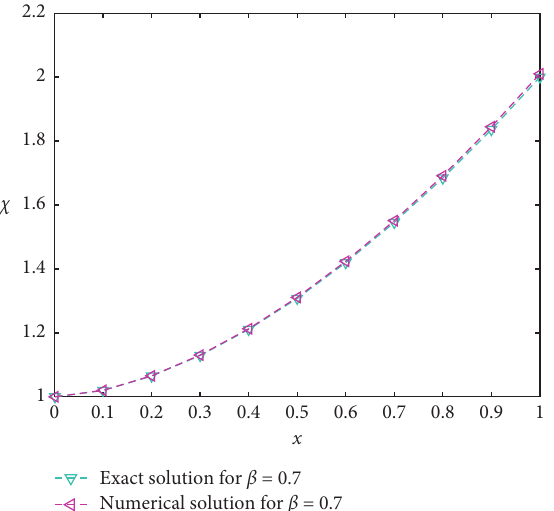
Figure 9: The numerical and exact solutions for fractional order β � 0 .